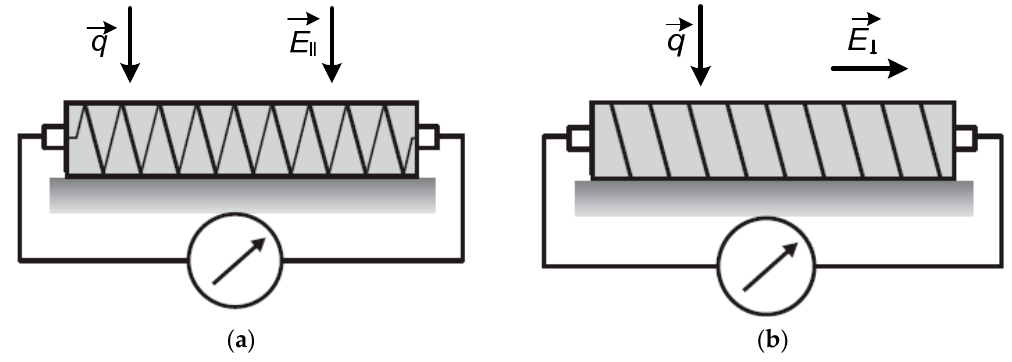
Figure 1. Heat flux sensors: ( a ) longitudinal; ( b ) and transverse [21]. Copyright Springer 2012.